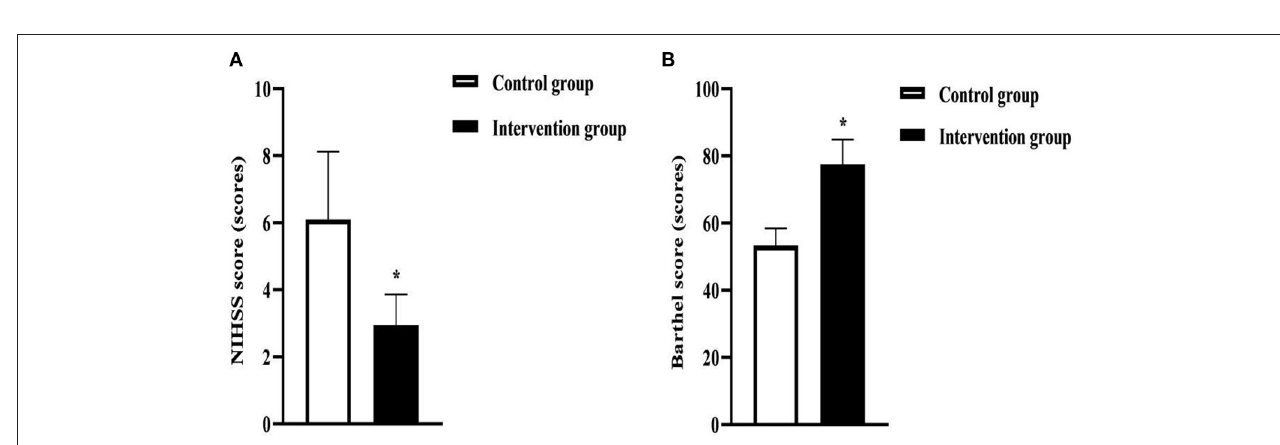
FIGURE 4 | NIHSS and Barthel scores in the two groups of patients. (A) was the NIHSS score. (B) was the Barthel score. * was the comparison of similar items between groups, P < 0.05.